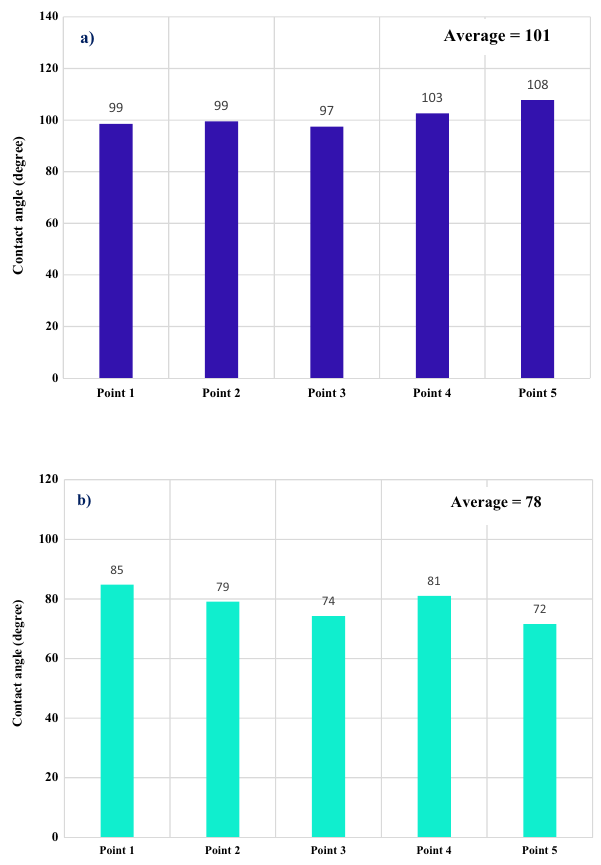
Figure 9: Comparison of contact angle of ( a ) oil - wet surface and ( b ) surface treated with the polymer